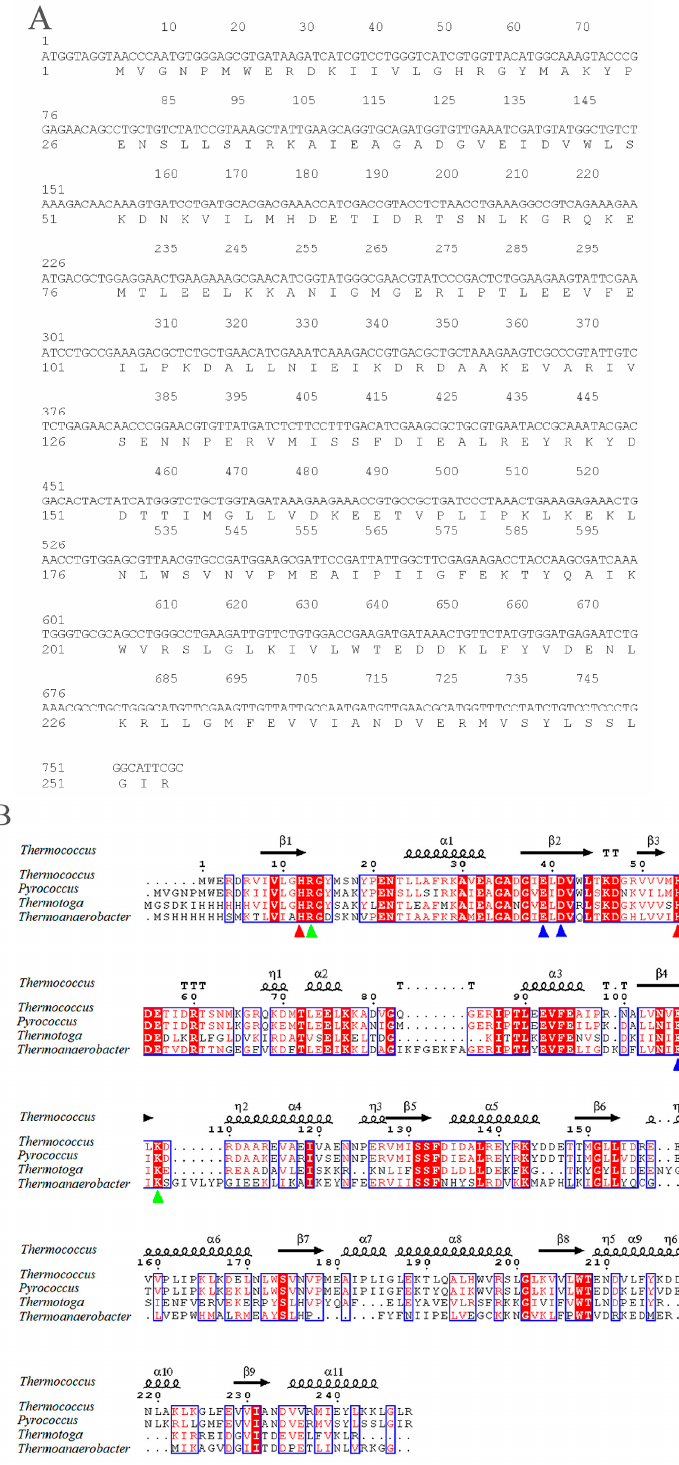
Figure 1. Information on the synthetic sequence of glycerophosphodiester phosphodiesterases from Pyrococcus furiosus DSM 3638 (pfGDPD) ( A ) and multiple sequence alignment of pfGDPD amino acid sequence with those of known GDPD proteins available in Protein Data Bank (PDB); ( B ) Identical residues were marked with a red background, and the highly conserved residues were showed in red font. Secondary structures of GDPD are shown above the alignments. The catalytic triads of two histidines are indicated with red triangles. Triangles in green indicate strictly conserved residues in GDPDs. Triangles in blue indicated the divalent cation-binding related residues in that cleft of GDPDs. GDPD from Thermococcus kodakarensis KOD1(PDB: 4OEC); GDPD from Thermotoga maritima (PDB: 1O1Z); GDPD from Thermoanaerobacter tengcongensis (PDB: 2PZ0) were used for alignment.